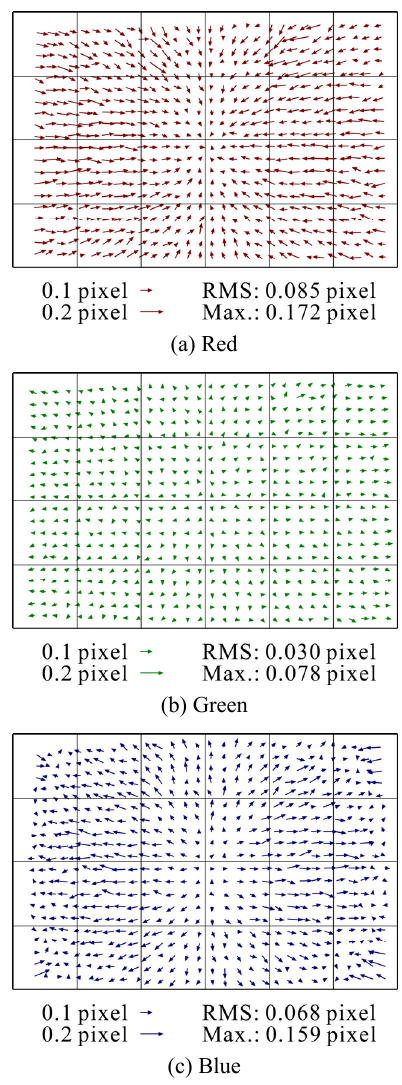
Figure 6. Displacement vectors caused by lossy JPEG compression with 2x1 1x1 1x1